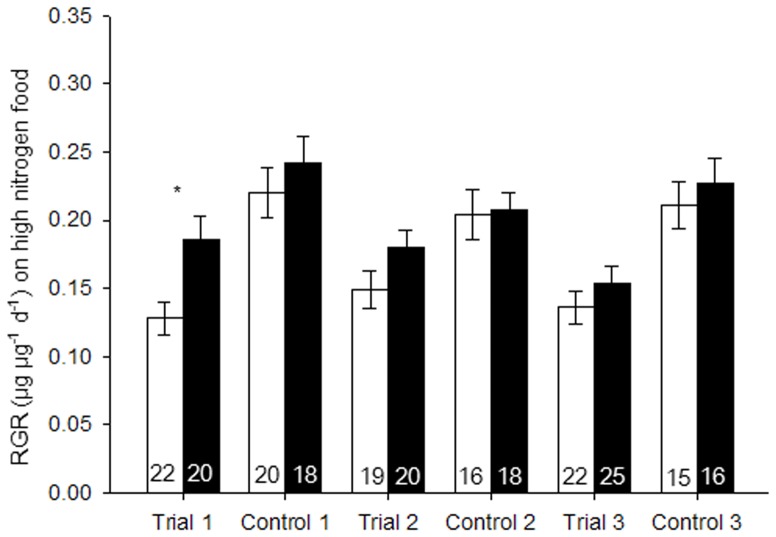
Mean relative growth rate (RGR) of B. tabaci females reared on standard diet (control) or high-nitrogen diet.Black bars and white bars indicate infected and noninfected females, respectively. Replicate numbers are noted within the columns. Values are means±SE. The experiment was performed three times (trial 1–3). For each paired comparison (± infection), asterisks indicate a significant difference (*, p<0.05) based on a t-test.